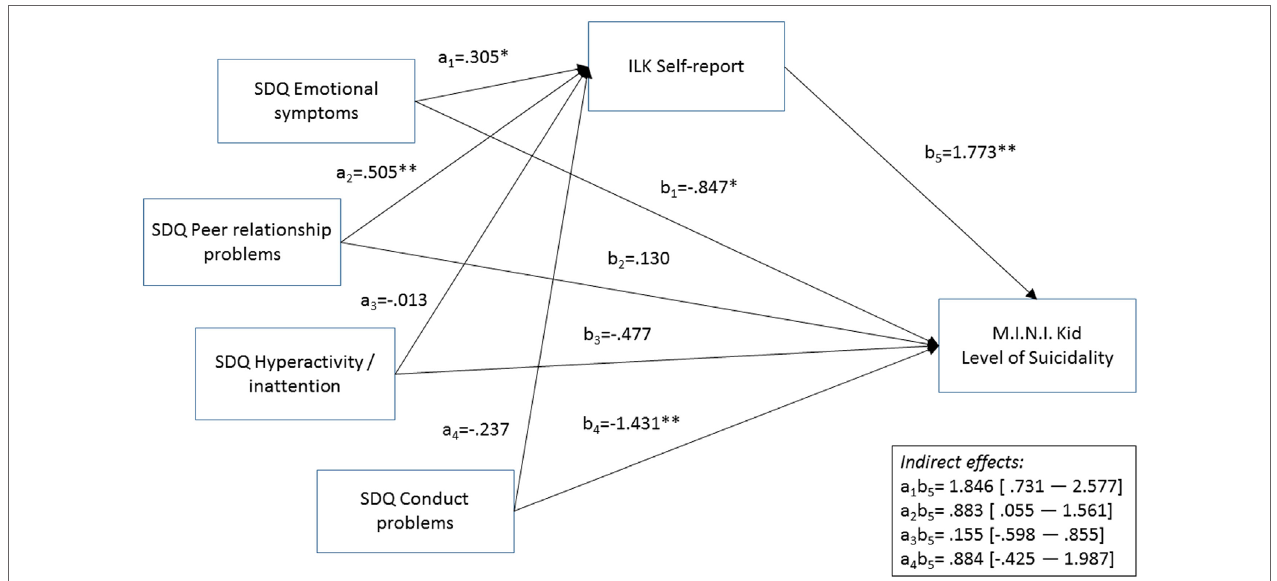
FigUre 2 | Results of the mediational analysis. * p < 0.05, ** p < 0.01. a j , b i : unstandardizcd regression coefficients. Abbreviations: ILK, Inventar zur Erfassung der Lebensqualität von Kindern und Jugendlichcn; SDQ, Strengths and Difficulties Questionnaire; M.I.N.I. Kid, Mini International Neuropsychiatric Interview Kid. Gender and age were included as covariates, but are not presented in Figure because of reasons of